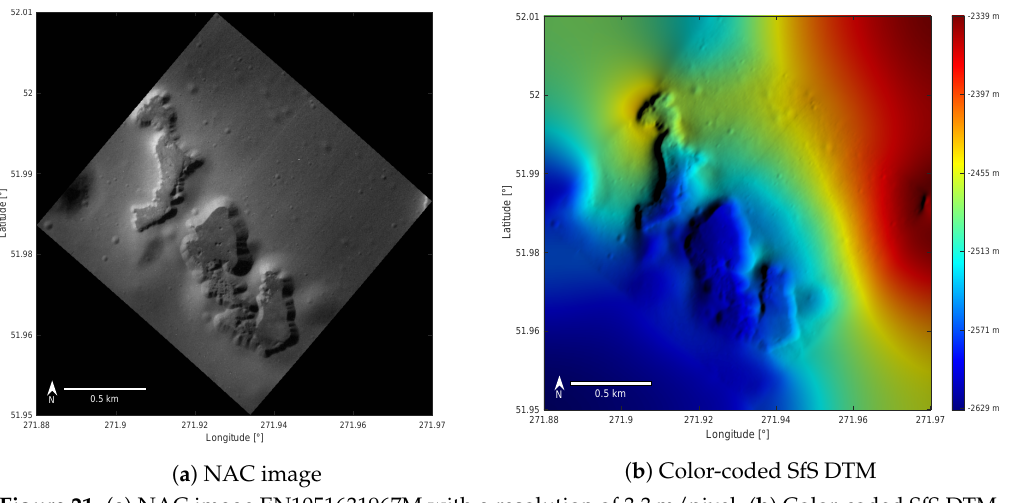
Figure 21. ( a ) NAC image EN1051631967M with a resolution of 3.3m/pixel. ( b ) Color-coded SfS DTM. The faint streaks running through the DTM parallel to the image borders are caused by artifacts in the original